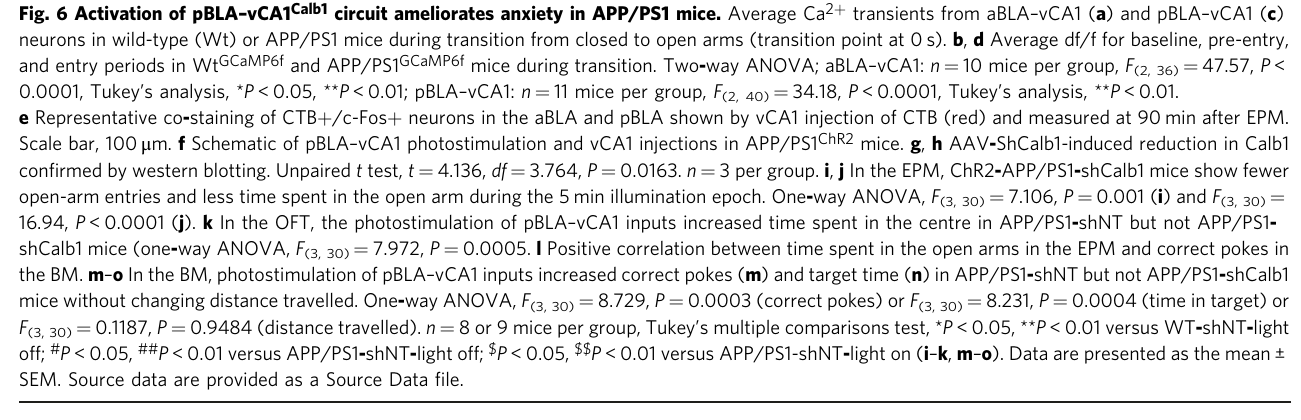
Fig. 6 Activation of pBLA – vCA1 Calb1 circuit ameliorates anxiety in APP/PS1 mice. Average Ca 2 + transients from aBLA – vCA1 ( a ) and pBLA – vCA1 ( c ) neurons in wild-type (Wt) or APP/PS1 mice during transition from closed to open arms (transition point at 0 s). b , d Average df/f for baseline, pre-entry, and entry periods in Wt GCaMP6f and APP/PS1 GCaMP6f mice during transition. Two - way ANOVA; aBLA – vCA1: n = 10 mice per group, F (2, 36) = 47.57, P